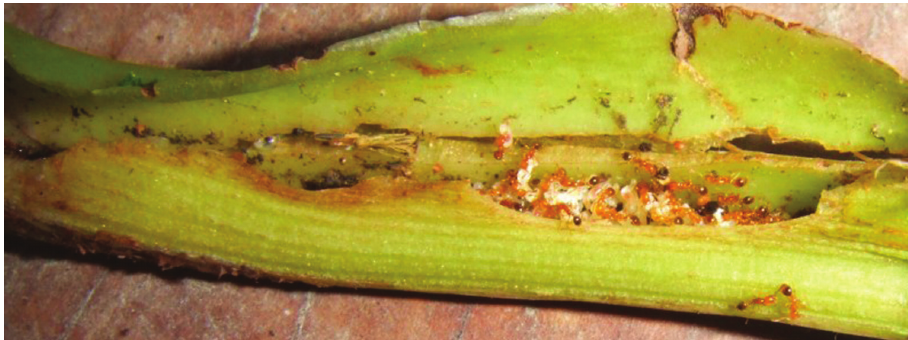
Figure 5. A colony of Pheidole ants nesting inside a petiole of P. kelleyi